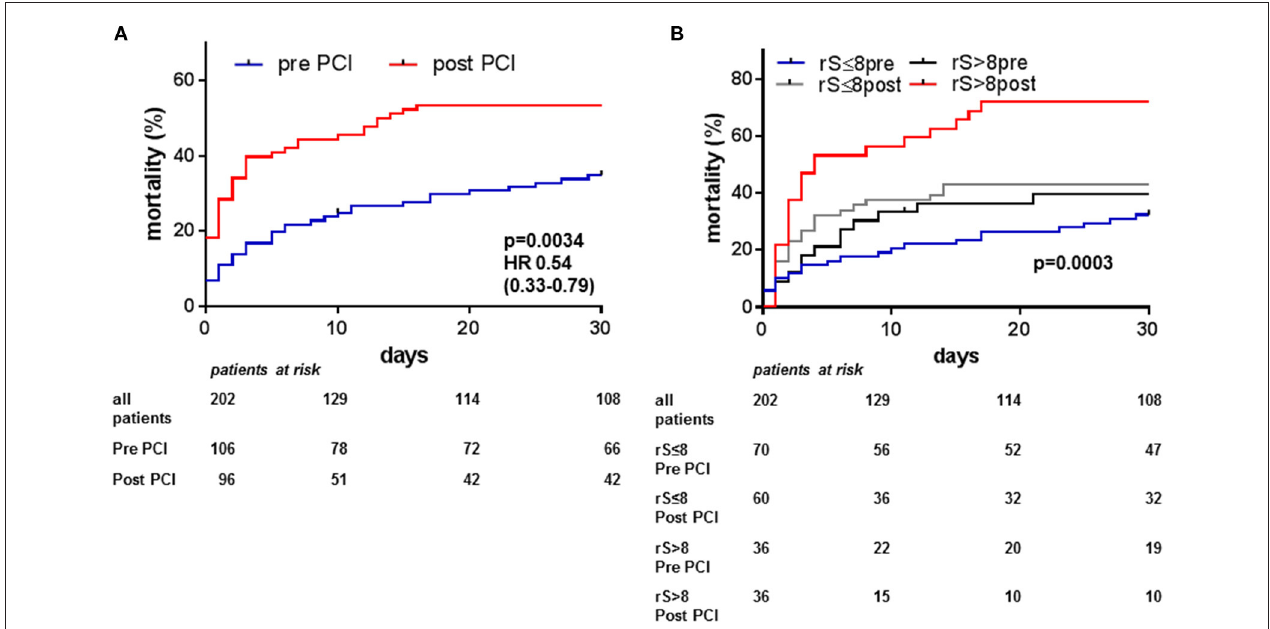
FIGURE 2 | Thirty-day mortality in acute myocardial infarction cardiogenic shock (AMI-CS) on Impella depending on timing of Impella support and completeness of revascularisation: Observed 30-days mortality in AMI-CS treated with Impella was lower if Impella was implanted pre PCI compared to post PCI (A) . Lowest mortality was observed in patients receiving Impella pre PCI and achieving complete revascularisation defined by an residual Syntax score (rS) ≤ 8 (B)